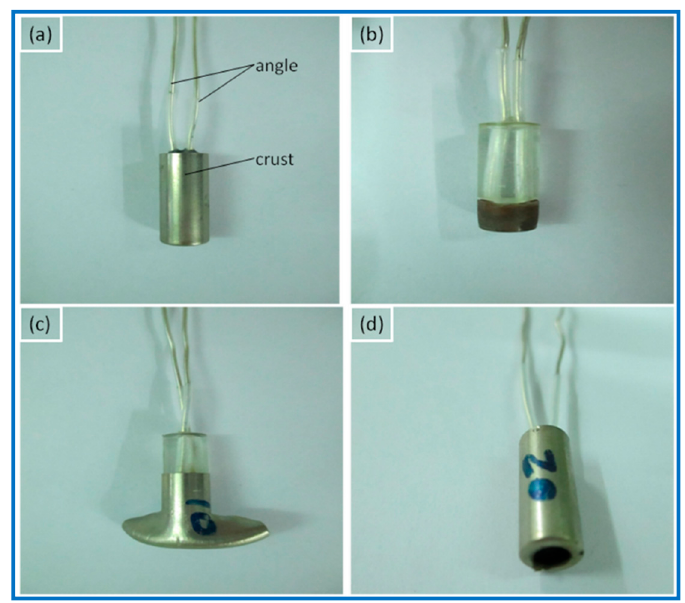
Figure 4. Firing pictures at the angle–angle connection for Al/Fe 2 O 3 /RDX nanocomposites with RDX content of ( a ) R-100, ( b ) >50 wt % RDX, ( c ) R-30, ( d ) R-0.